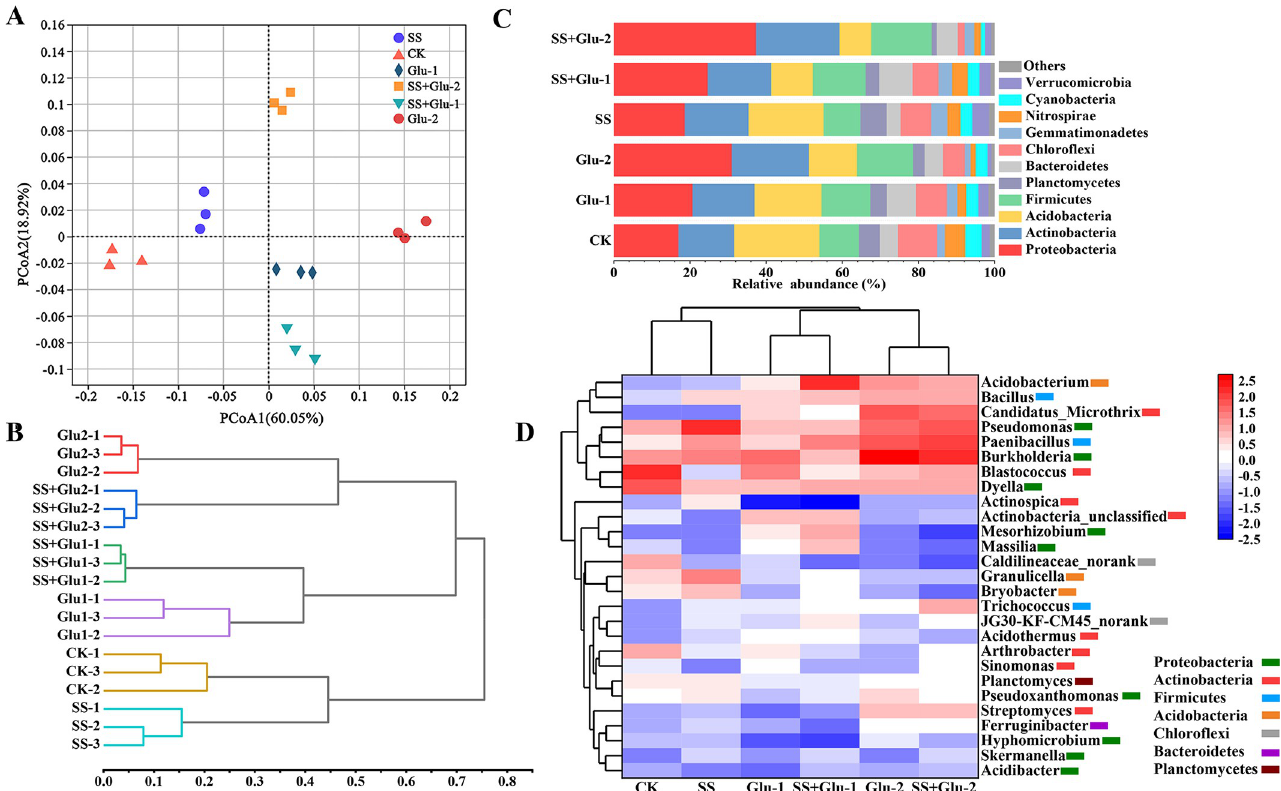
Fig 3. Principal coordinates analysis (PCoA, A), hierarchical cluster (B), the relative abundance of bacterial community composition at a phylum level (relative abundance exceeding to 1%, C), and heatmap of the relative abundance of bacterial genera (relative abundance exceeding to 1%, D) in the soils with glucose addition and sterilization at day 45. CK, non-sterilized soil without glucose addition; Glu-1, non-sterilized soil with low level of glucose addition; Glu-2, non- sterilized soil with high level of glucose addition; SS, sterilized soil without glucose addition; SS+Glu-1, sterilized soil with low level of glucose; SS+Glu-2, sterilized soil sterilization with high level of glucose